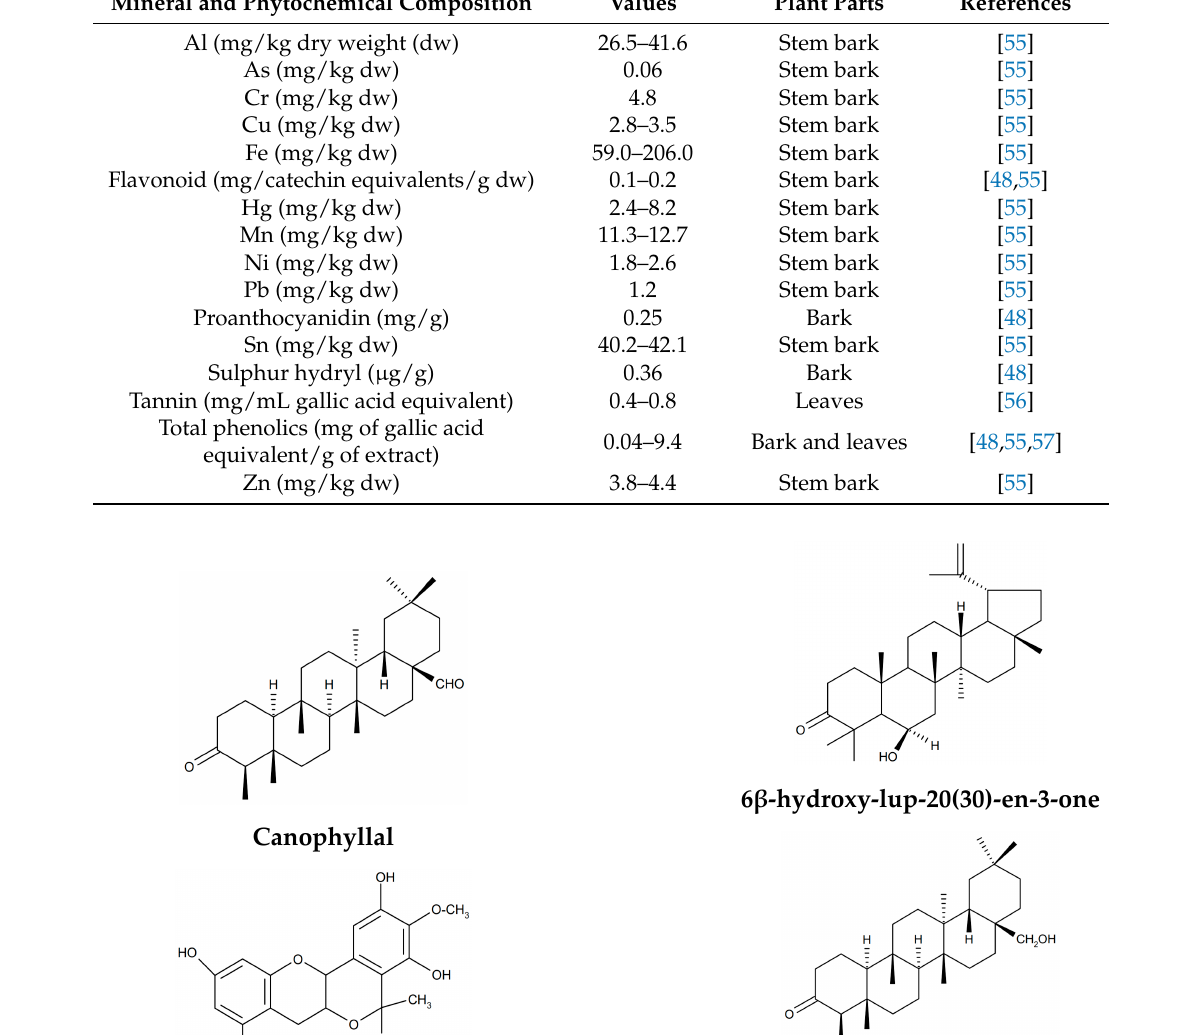
Table 2. Mineral and phytochemical composition of Elaeodendron transvaalense . Mineral and Phytochemical Composition